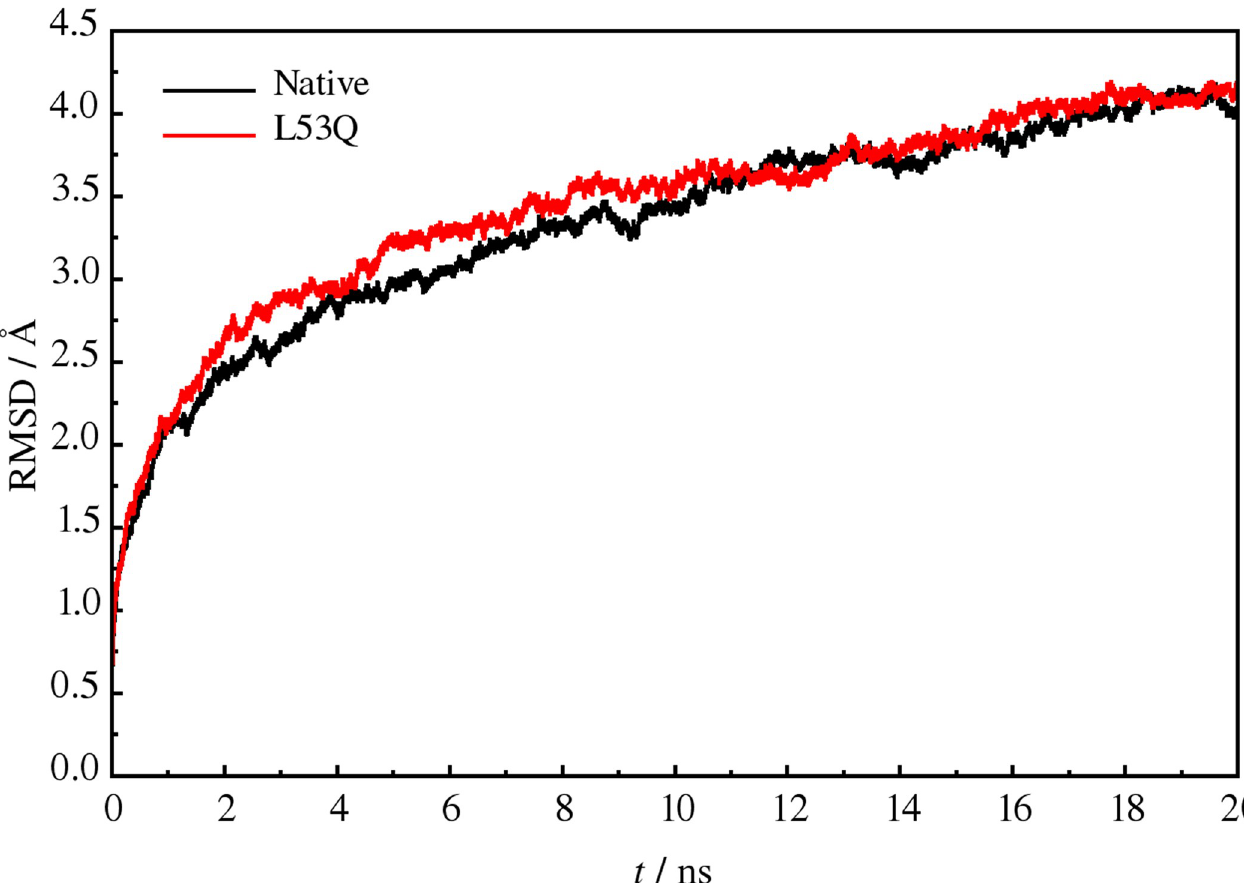
Fig 5. Average root mean square deviation plot. The black and red tracings are for wild-type and L53Q structures, respectively. Around 18 ns both structures seem to become stable.